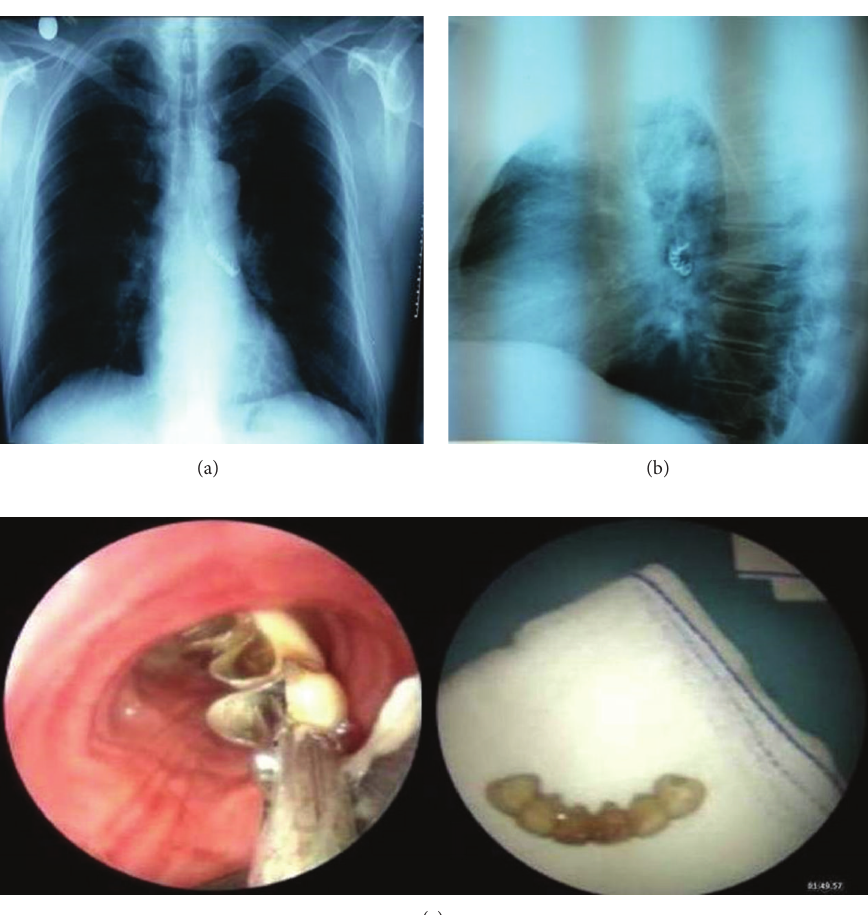
Figure 1: PA (a) and lateral (b) chest X-ray view in the left main bronchus radiopaque foreign body was considered as a dental prosthesis. (c) Extracted dental prosthesis with